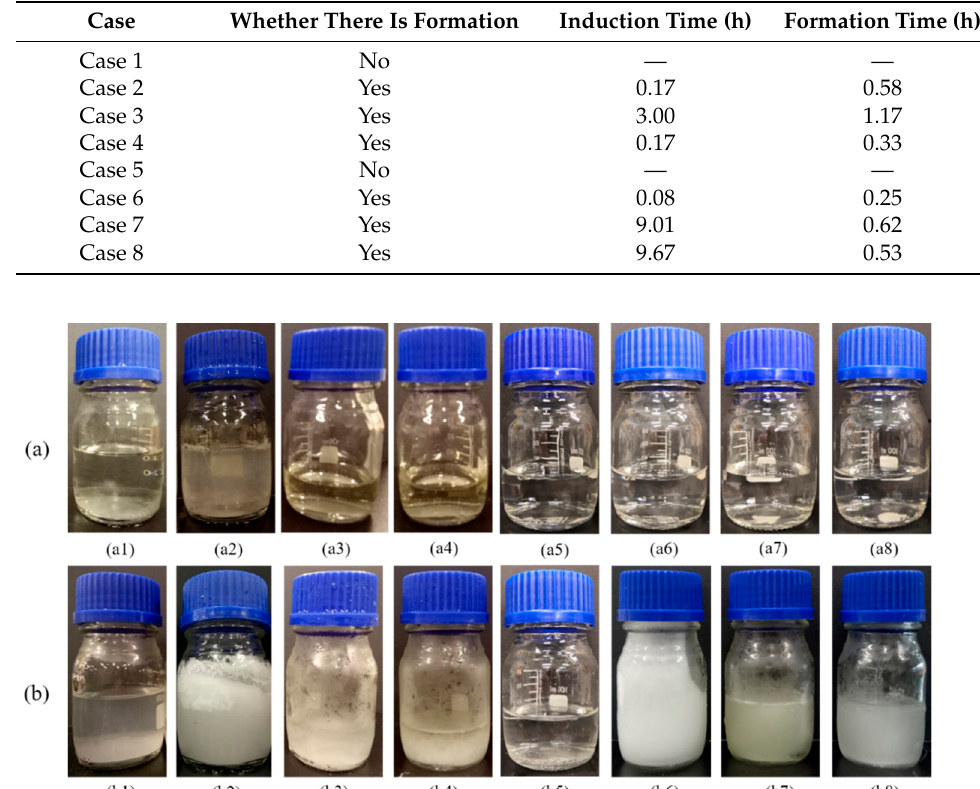
Table 3. The data on characteristics of hydrate formation experiments.